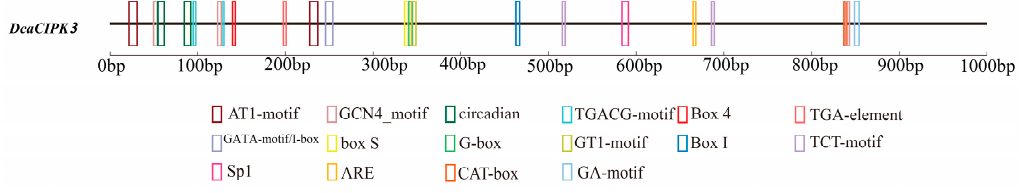
Figure 8. Analysis of the important cis -regulatory elements in the sequence 1 kb upstream of